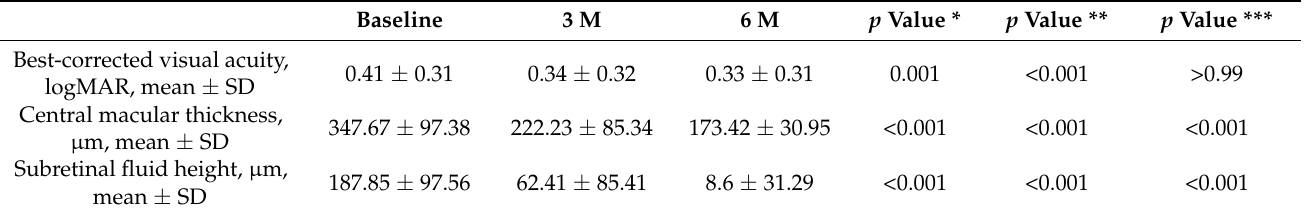
Table 3. Best-corrected visual acuity, central macular thickness, and subretinal fluid height change during follow-up of patients with chronic central serous chorioretinopathy treated with selective retina therapy with real-time feedback